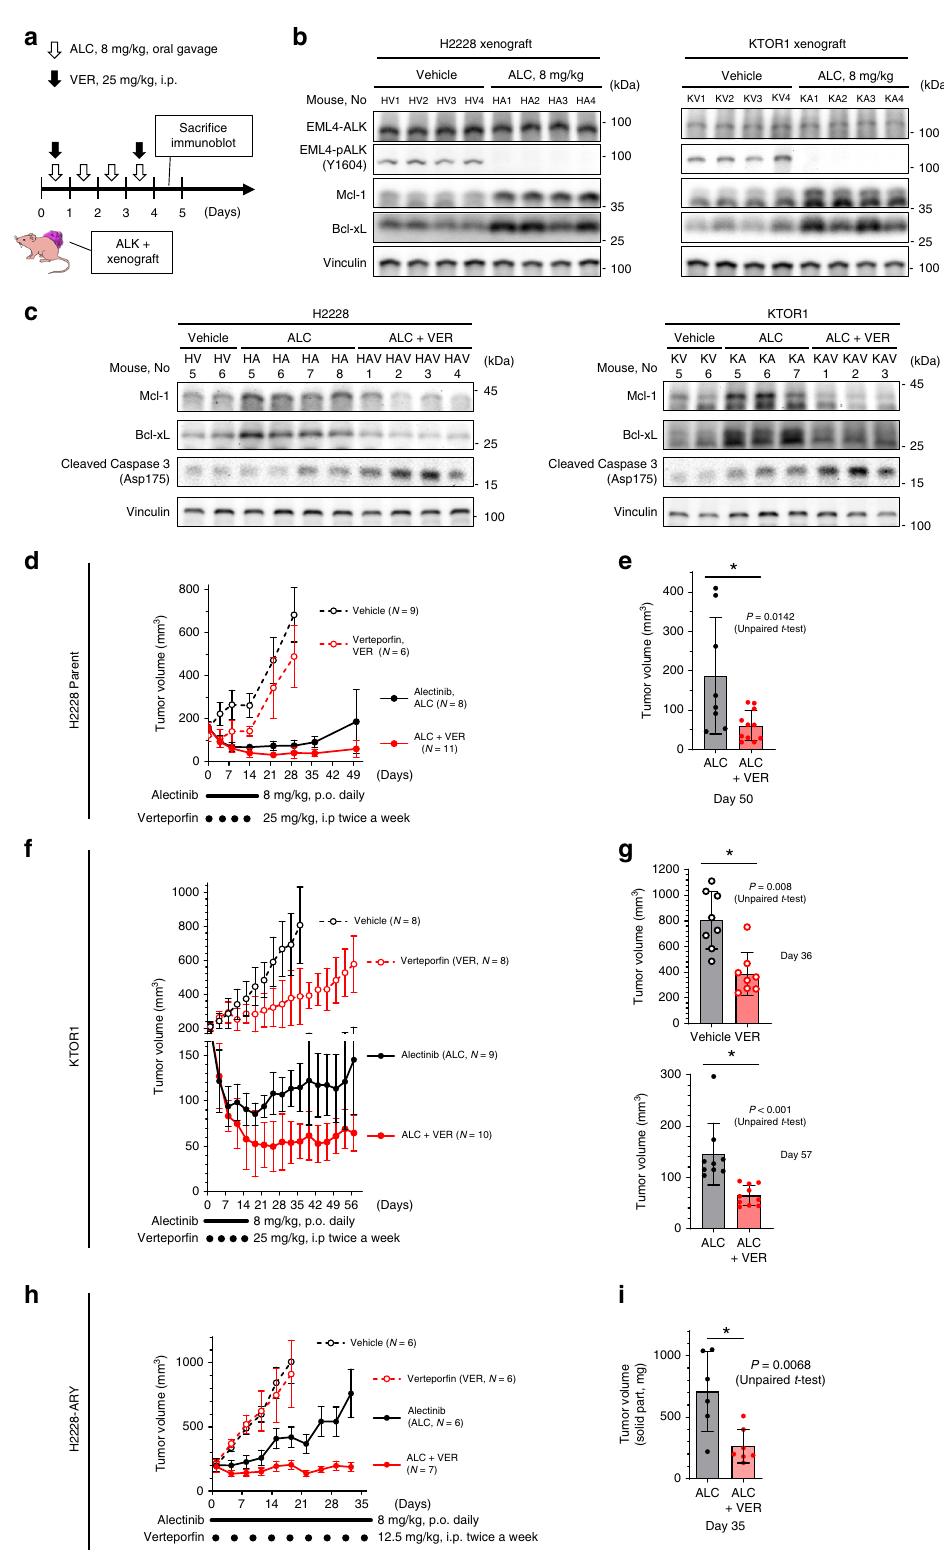
Proteome analysis . Cells were solubilized with lysis buffer (8 M urea and 4% (w/v) SDS in 50mM Tris – HCl, pH 7.5) and incubated at 95°C for protein extraction. Cell lysates were sonicated on ice using the Bioruptor UCD-250T (Cosmo Bio, Tokyo, Japan). The solution was subjected to chloroform/methanol precipitation 63 . Proteins were reduced by dithiothreitol (50 mM) at 37 °C for 30min,